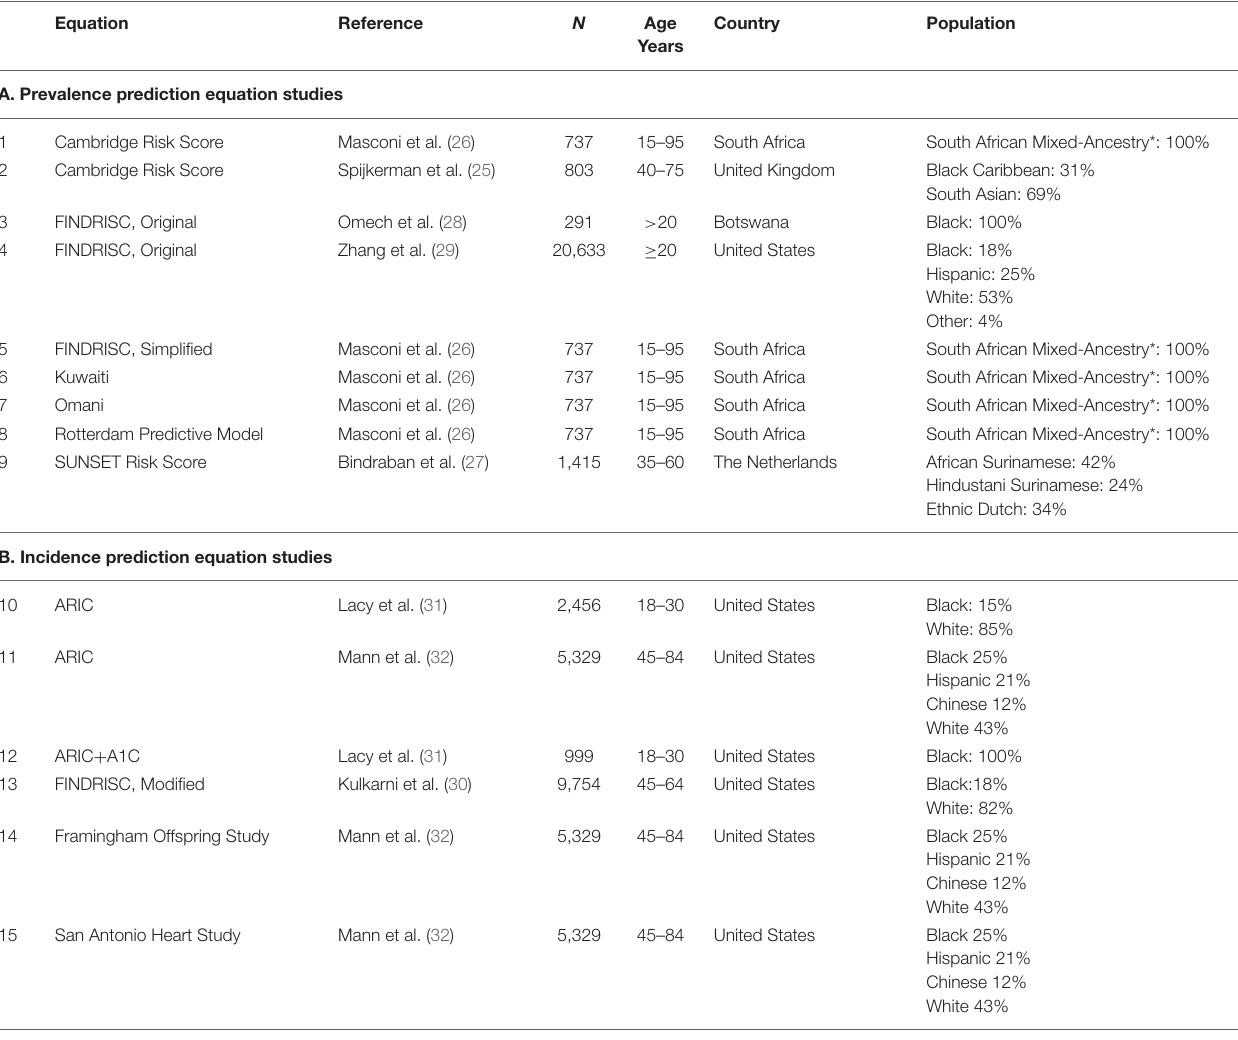
TABLE 1 | Prevalence and incidence diabetes prediction equation studies: study populations.